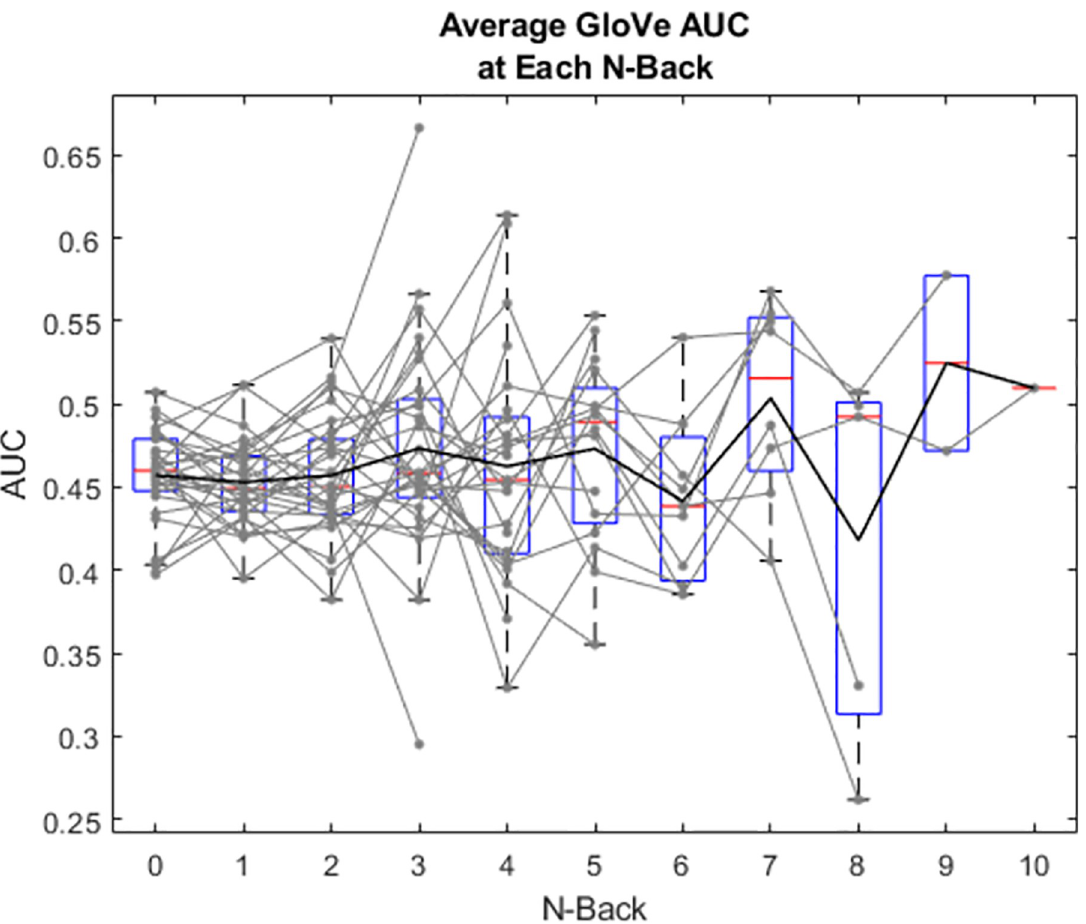
Fig 6. Area under the ROC curve for GloVe-based predictions of gaze at each N-back. As Fig